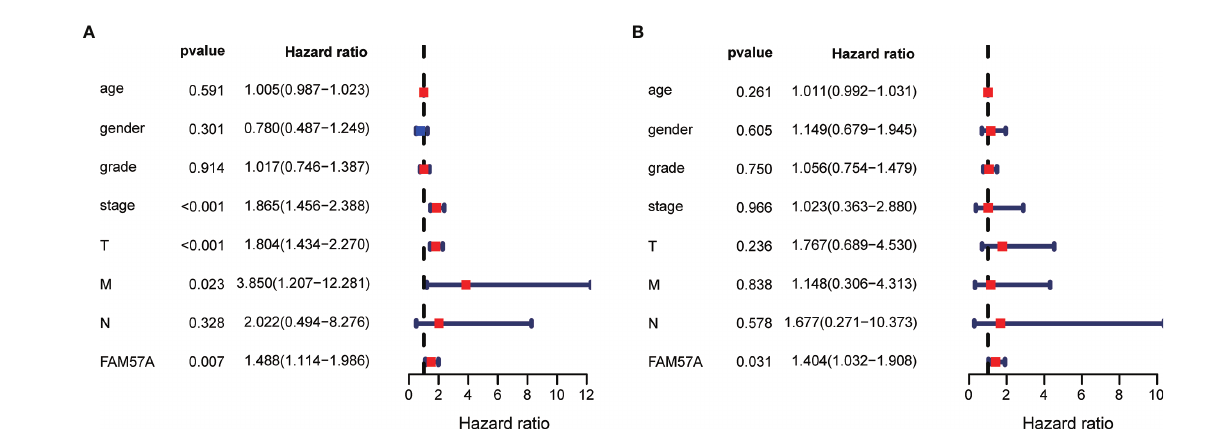
FIGURE 5 | Univariate and multivariate Cox regression analyses of the FAM57A level and other clinicopathological characteristics. (A) Univariate Cox regression analysis. (B) Multivariate Cox regression